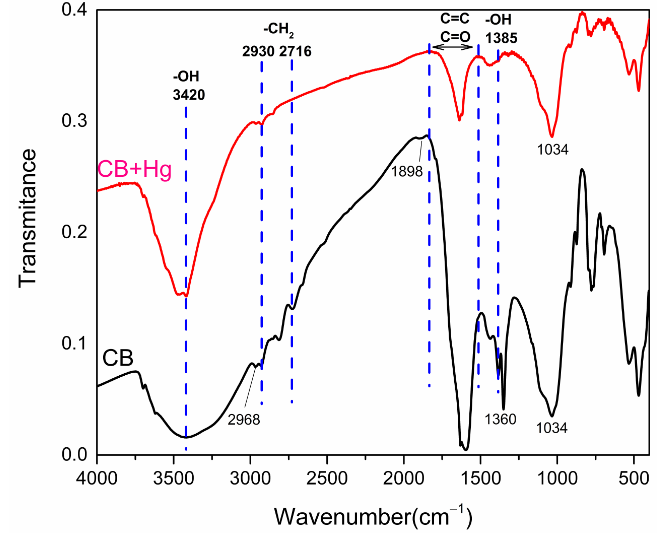
Figure 4. The FTIR spectra of CB before and after Hg 2+ adsorption.